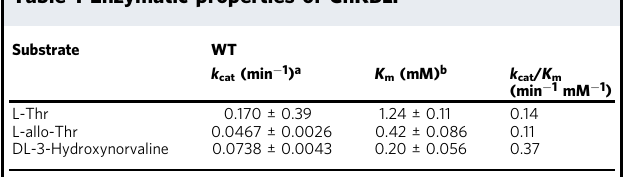
Table 1 Enzymatic properties of CnKBL.